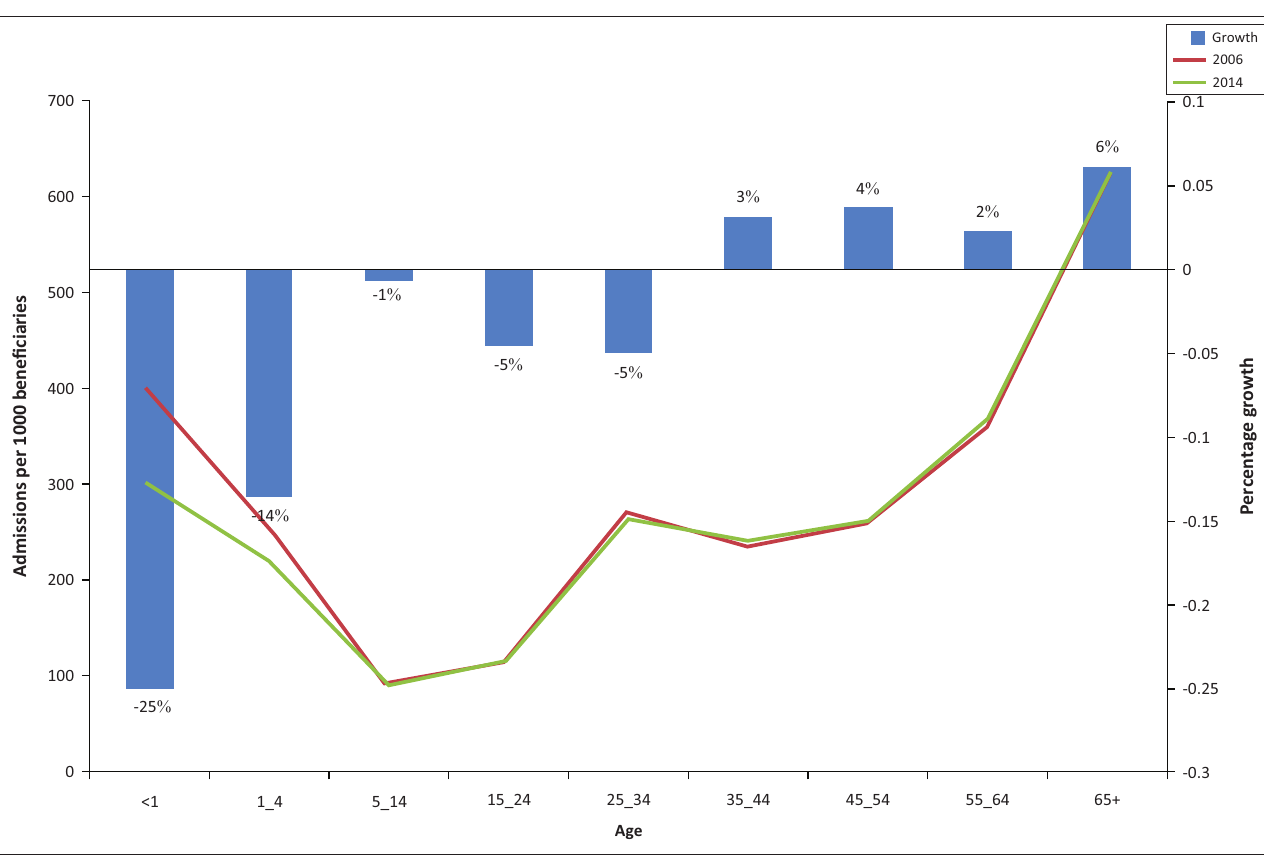
FIGURE 5: Admissions per age group, per 1000 beneficiaries; 2006 and